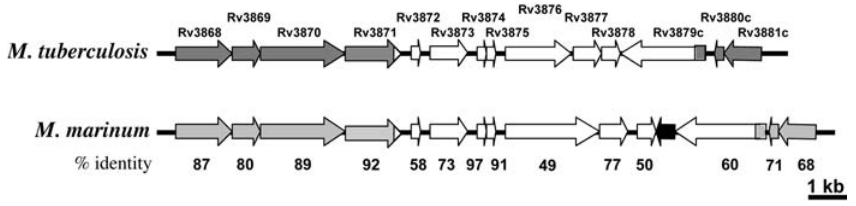
Figure 1. The RD1 Regions in M. tuber- culosis and M. marinum Are Homologous and Syntenic The white arrows represent the RD1 region deleted from M. tuberculosis . The black arrow represents a predicted open reading frame not present in M. tuber- culosis. Rv3874 and Rv3875 are also known as cfp-10 and esat-6, respectively. Numbers represent the percent amino acid identities between the correspond-